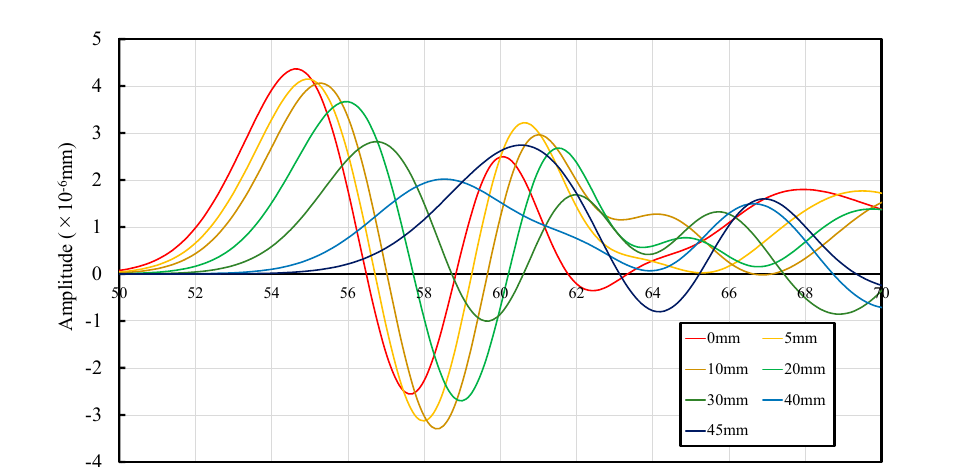
Figure 9. Measured waveform: ( a ) analysis model (dry depth = 5 mm), ( b ) analysis model (dry depth = 10 mm), ( c ) analysis model (dry depth = 20 mm), ( d ) analysis model (dry depth = 30 mm), ( e ) analysis model (dry depth = 40 mm), and ( f ) analysis model (dry depth = 45 mm).